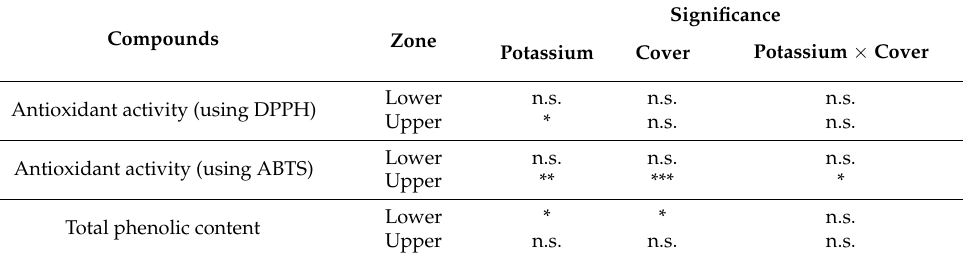
Table 4. The statistical significance of each factor and their interaction for the analysis of antioxidant activity and total phenolic content. Abbreviations: TE (Trolox equivalents); GAE (gallic acid equiva- lents); ABTS (2,2- Azino bis (3- ethylbenzothiazolin-6- sulfathan); DPPH (1,1-diphenyl-2-picrylidracil); FW (fresh